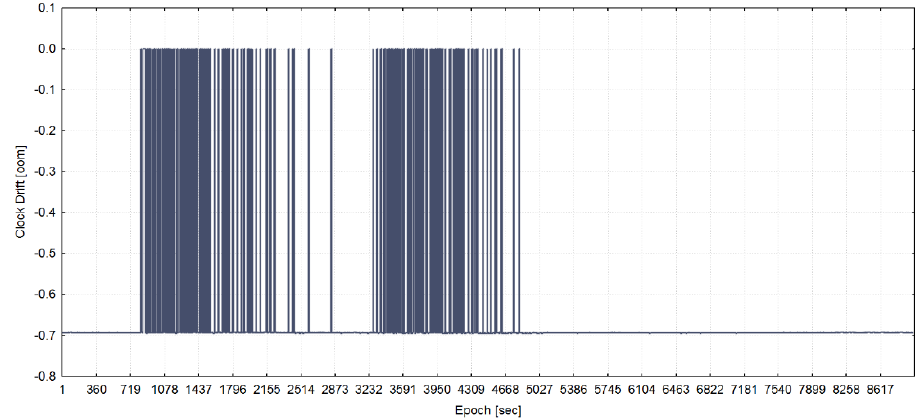
Figure 6. Receiver clock drift from the training dataset with a programmed 1 ns/s of time pulling (adapted from [13]).